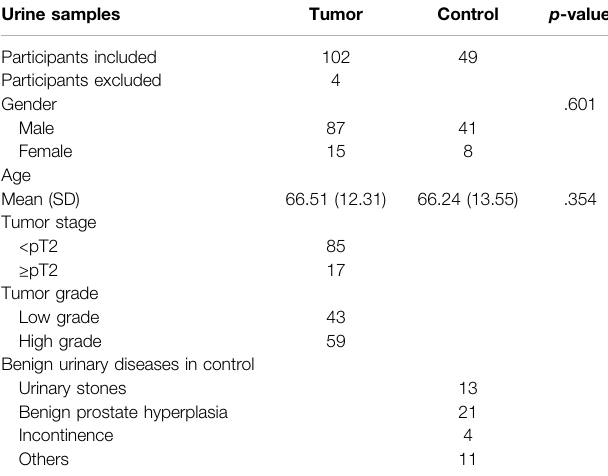
TABLE 1 | Patient baseline characteristics.